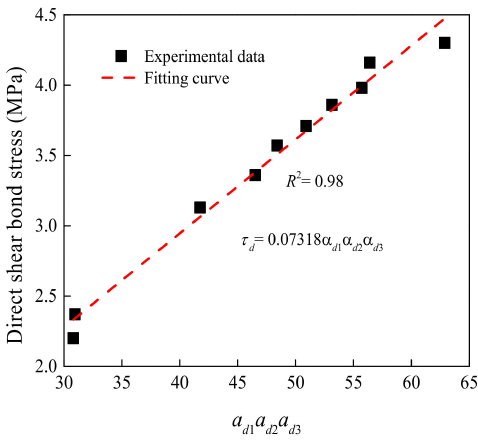
Figure 15. Relationship between shear bond stress and three parameters.